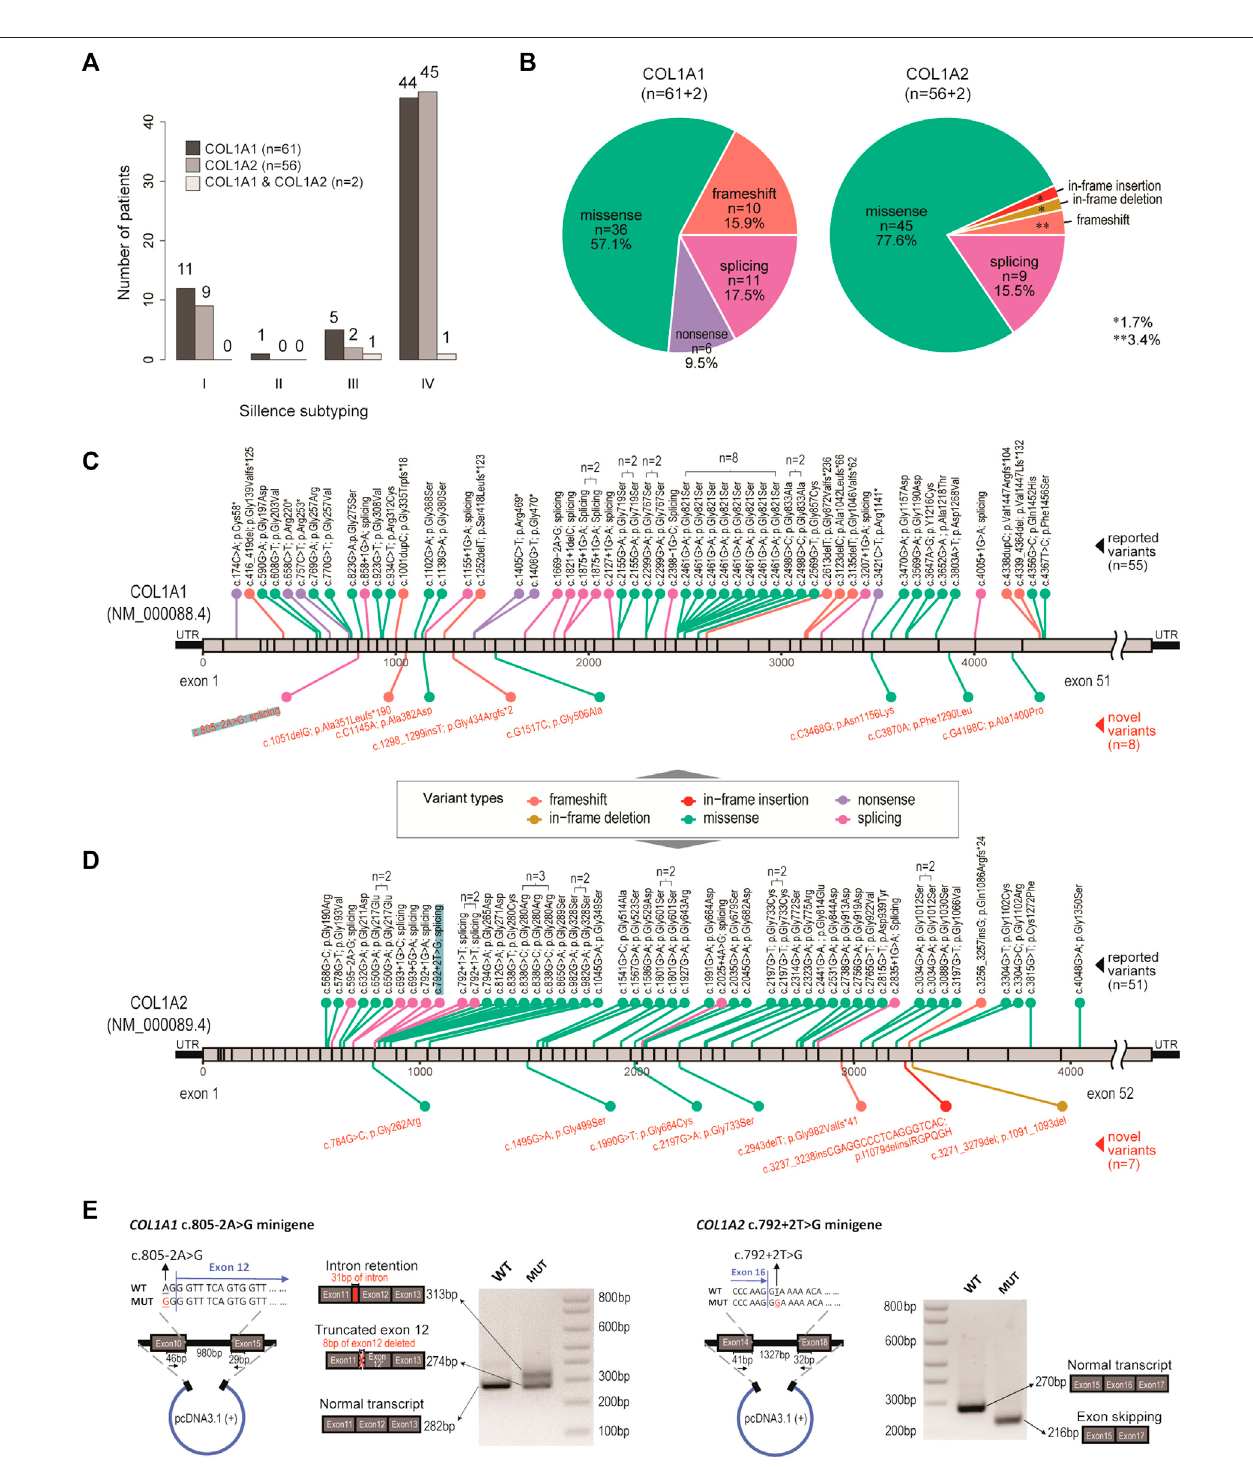
FIGURE 1 | Genetic spectrum in our OI cohort. (A) Bar charts showing the distribution of OI cases, with respect to genotypes and clinical subtyping (Sillence scales). (B) Piechartsshowingthedistributionofvarianttypes,withrespecttogenotypes. (C) Diagramshowinglocationandmutationinformationofthepathogenicvariantsidenti fi edin COL1A1. n number indicatesnumber of recurrencesin the cohort. Black texts indicate reported variants. Redtexts indicate novel variants. (D) Diagram showing location and mutationinformationofthepathogenicvariantsidenti fi edinCOL1A2.nnumberindicatesnumberofrecurrencesinthecohort.Blacktextsindicatereportedvariants.Red texts indicate novel variants. (E) Validation of a novel splicing variant (COL1A1, c.805 – 2A > G) and a positive control (COL1A2, c.792+2T > G), which were also highlighted in (C) and (D) .